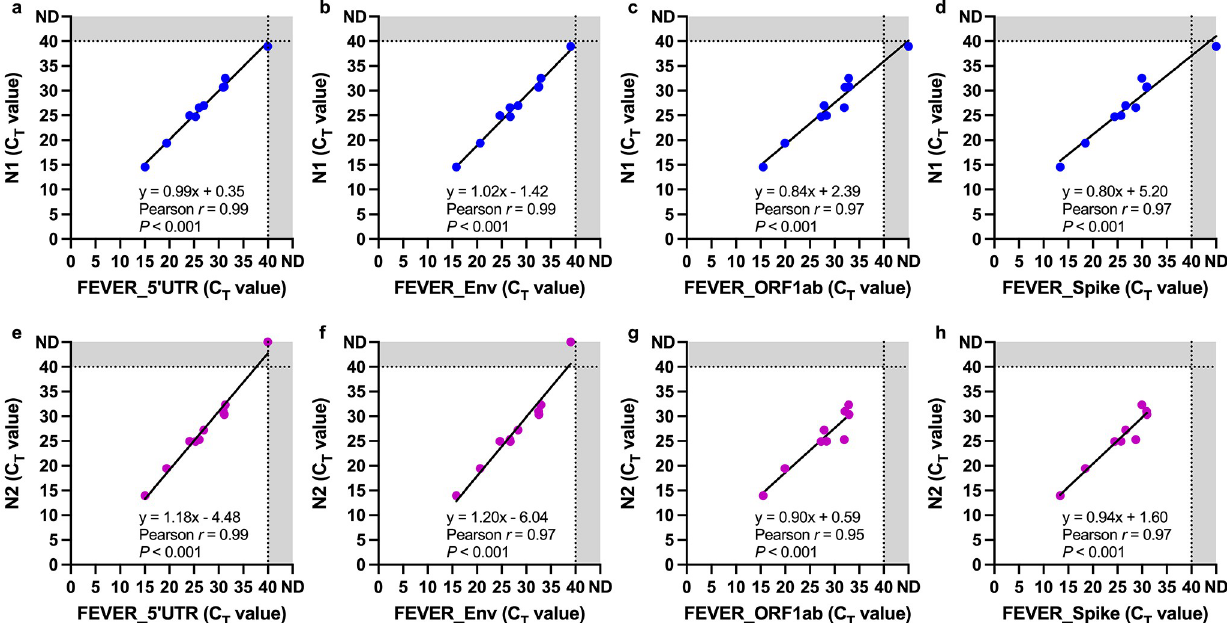
Fig 3. The FEVER and U.S. CDC assays show concordance in detecting SARS-CoV-2 in patient nasopharyngeal swab samples. The U.S. CDC N1 cycle threshold (C T ) values were compared to ( a ) FEVER_5’UTR, ( b ) FEVER_Env, ( c ) FEVER_ORF1ab, and ( d ) FEVER_Spike RT-PCR assays C T values (blue dots). The U.S. CDC N2 C T values were compared to ( e ) FEVER_5’UTR, ( f ) FEVER_Env, ( g ) FEVER_ORF1ab, and ( h ) FEVER_Spike RT-PCR assays C T values (purple dots). One sample was removed for the N2 vs FEVER_ORF1ab and N2 vs FEVER_Spike comparisons because it was not detected by these assays. Each dot represents an individual sample. Dotted lines represent the limit of detection. ND, not